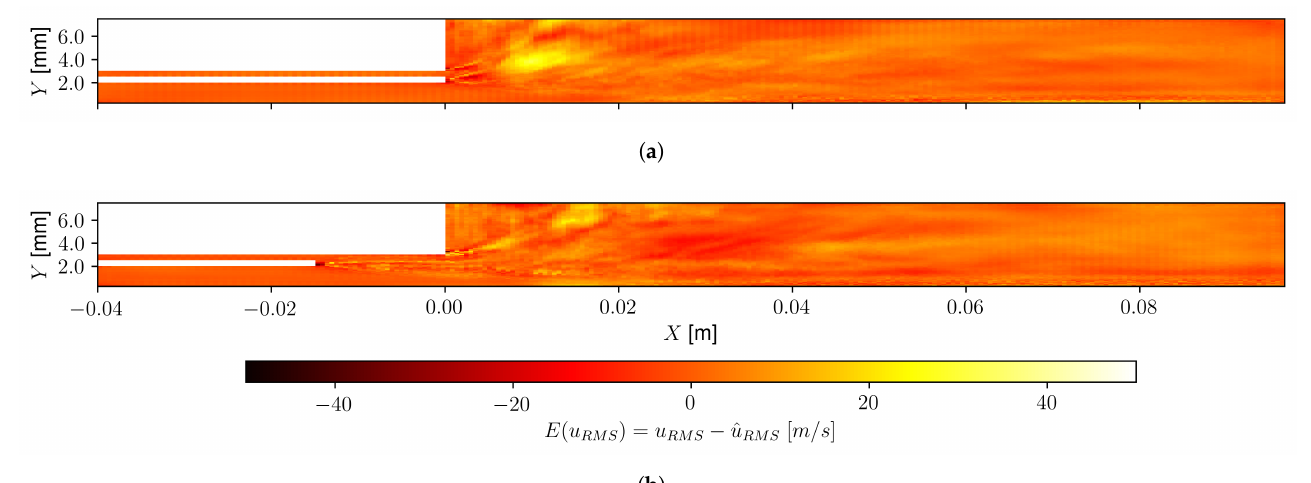
Figure 14. Predictive error of u RMS surrogate model with respect to the u RMS field from LES interpolated data. ( a ) DP-A and ( b ) DP-C. The color-scale has been deliberately saturated to ( − 50 m/s, 50 m/s) to better distinguish regions with prediction errors. The aspect ratio of the figures has been modified purposely to facilitate their scrutiny.